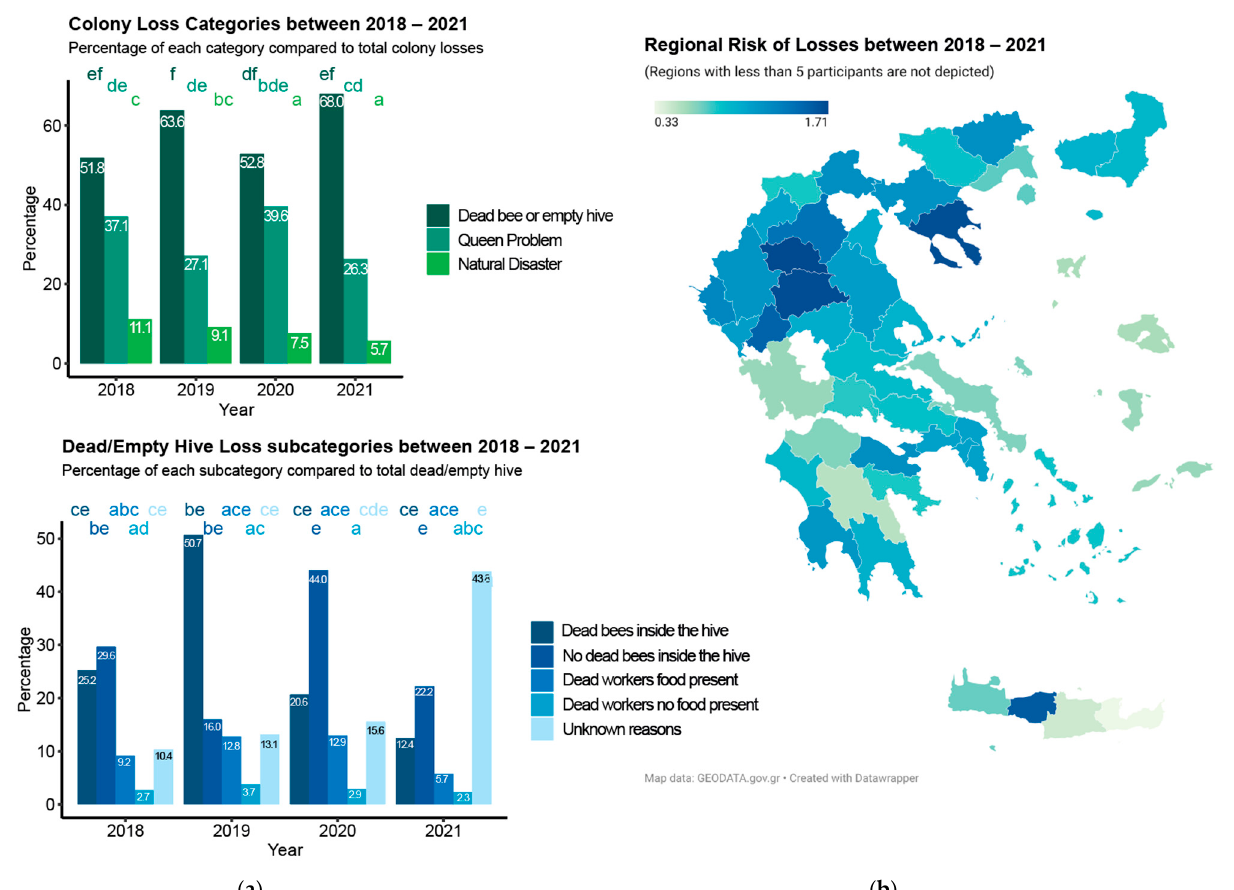
Figure 1. Constant distribution of the types of participants and monitored colonies across the years all over Greece: ( a ) stack bar plots showing the proportion of participants and; ( b ) monitored colonies in relation to their socio-professional situation (professional beekeepers > 150 hives); ( c ) map coverage of total participation across four years.